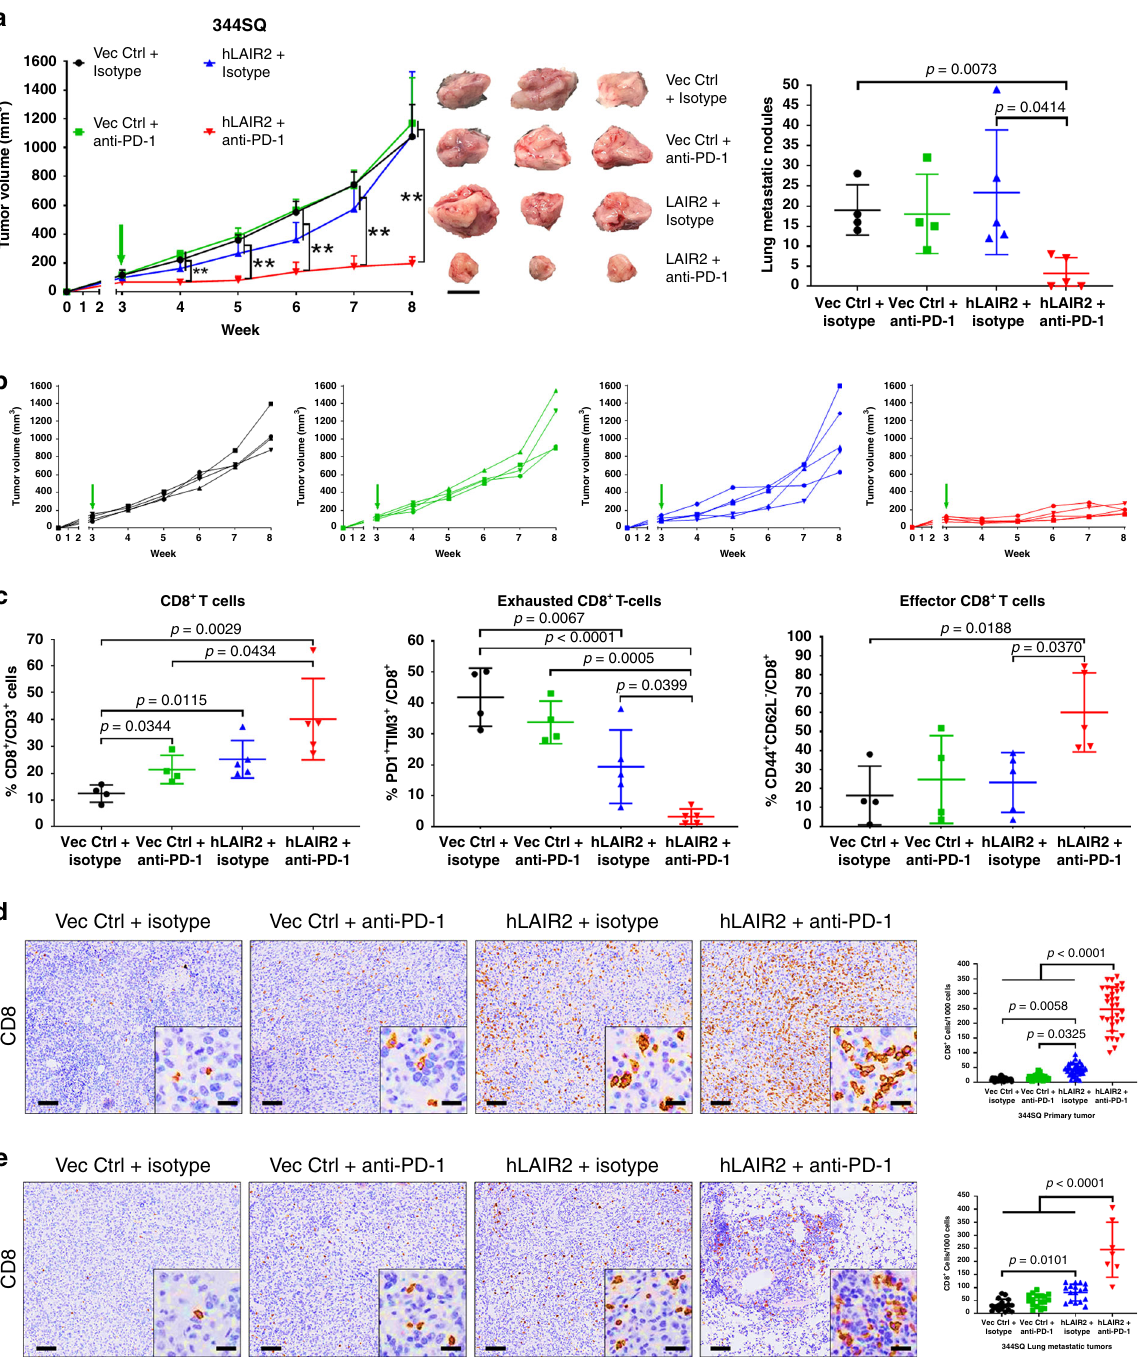
complete response when patients received anti-PD-1 therapies (Fig. 8a and b). Analysis of a separate dataset 48 comparing matched pre- and on-treatment melanoma patient samples showed a signi fi cant overall increase in LAIR1 and HAVCR2 (TIM-3) expression when patients received anti-PD-1 therapy (Fig. 8c), consistent with our experimental models. Although strati fi cation of pre- and on-treatment patient samples by col- lagen, LAIR1 , and HAVCR2 expression levels did not predict signi fi cant changes in overall survival (Supplementary Fig. 11g and h), net changes in LAIR1 and HAVCR2 expression (de fi ned as the difference in mRNA levels between pre- and on-treatment samples) predicted signi fi cant improvement in overall survival for